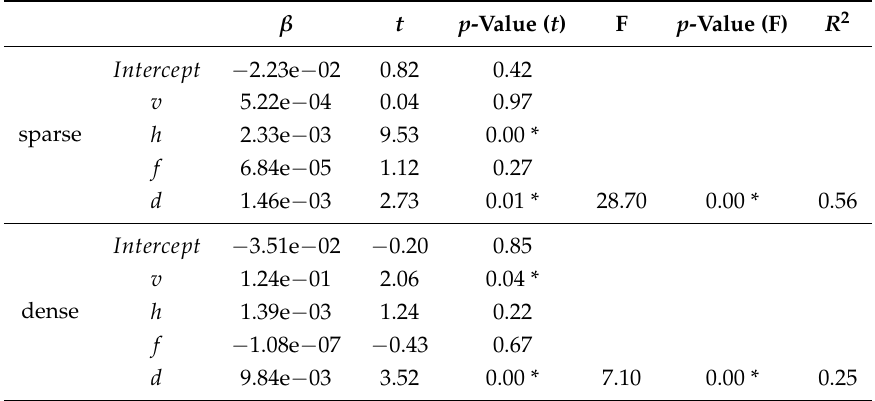
Table 3. Multiple linear regression model coefficients and predictive power for both sparse and dense visual odometry; * marks the statistical significance at α = 0.05.